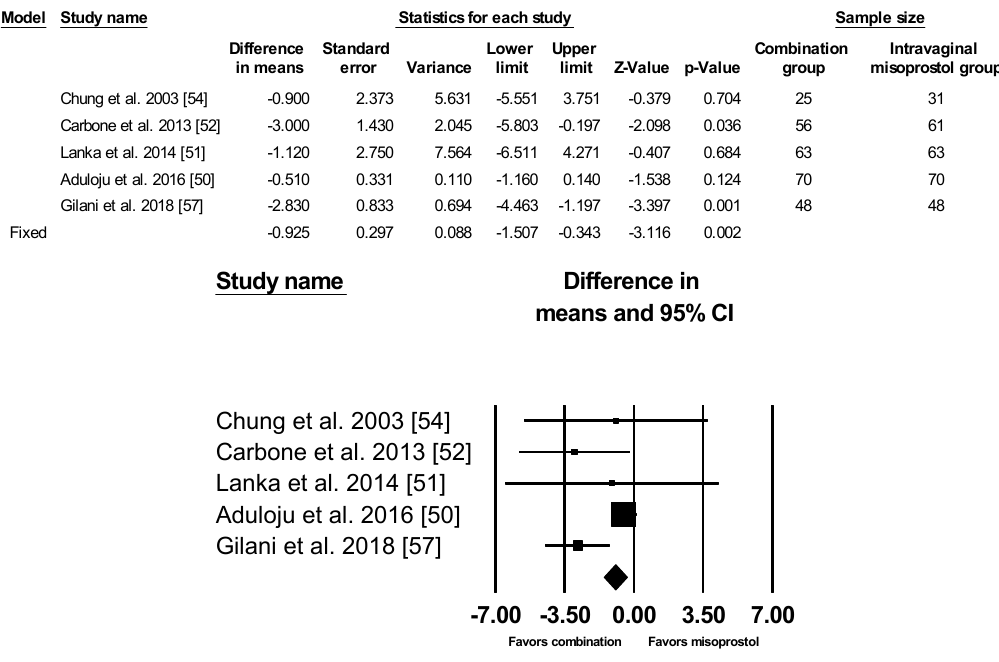
Figure 4. Comparison 3: Combination of intracervical Foley catheter and intravaginal misoprostol versus intravaginal misoprostol alone for cervical ripening, Outcome 3: Time to delivery in sample size < 200. Heterogeneity: Tau 2 = 1.282; χ 2 = 8.907 df = 4 ( p = 0.063); I 2 = 55.093%. Test for overall effect (random): Z = − 2.215 ( p = 0.027)